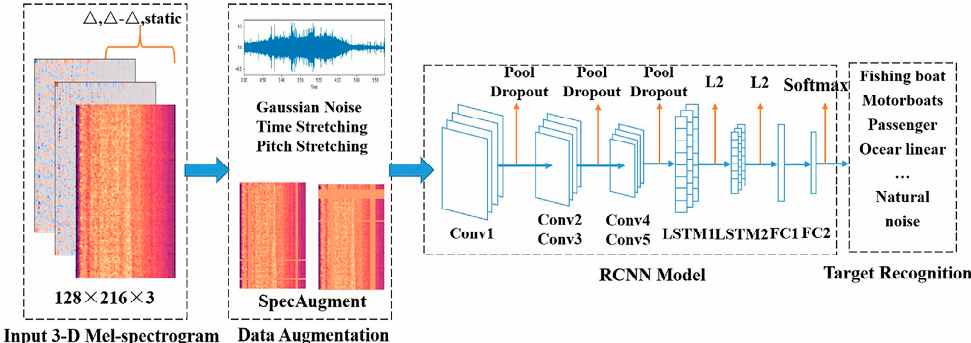
Figure 5. 3-D Meier spectrum-based classification proposed by Liu et al.